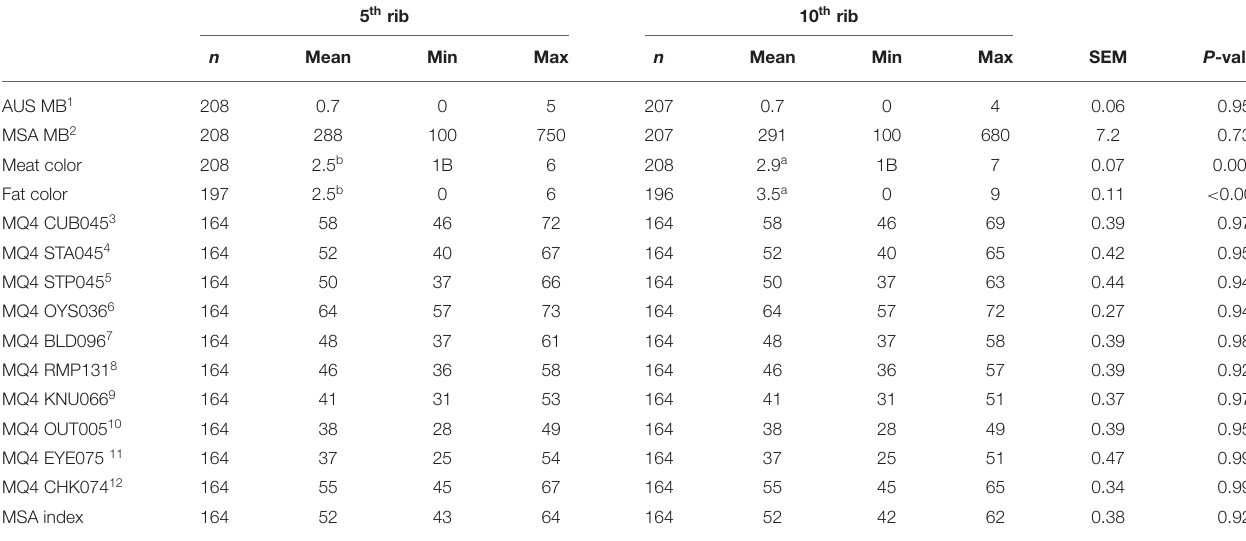
TABLE 2 | Number, mean, minimum, maximum scores, SEM of marbling, meat color, and fat color scores determined at the fifth and the tenth ribs.